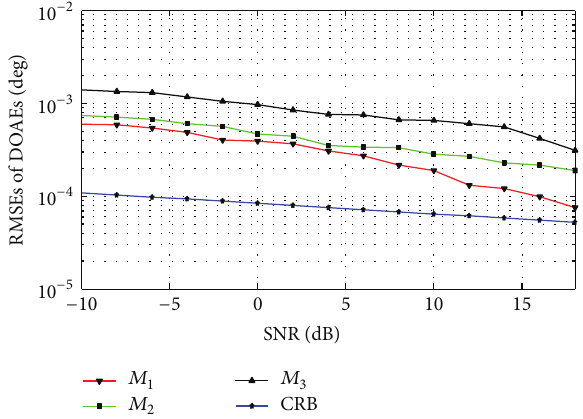
Figure 6: RMSEs versus SNR of T-ESPRIT for different maneuver cases.